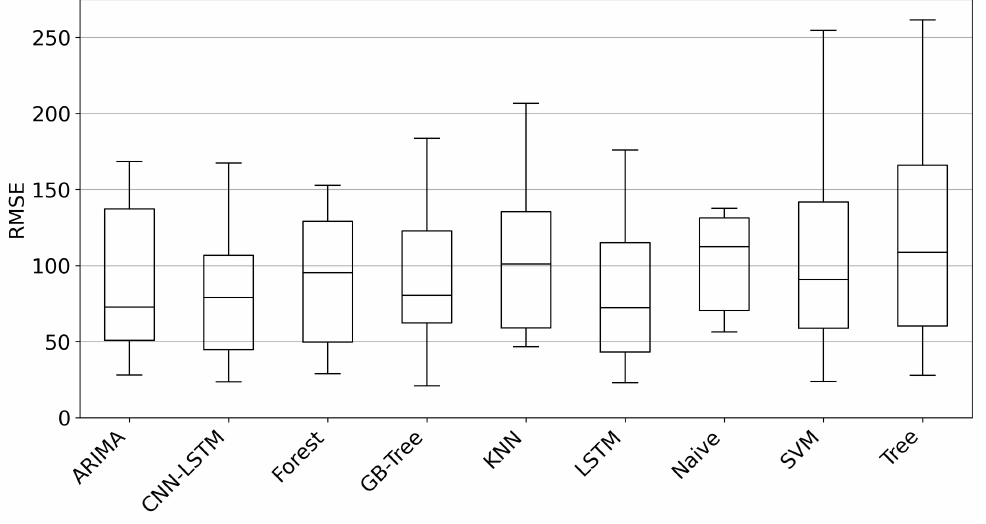
Figure 5. Performance deviation as a mean of model